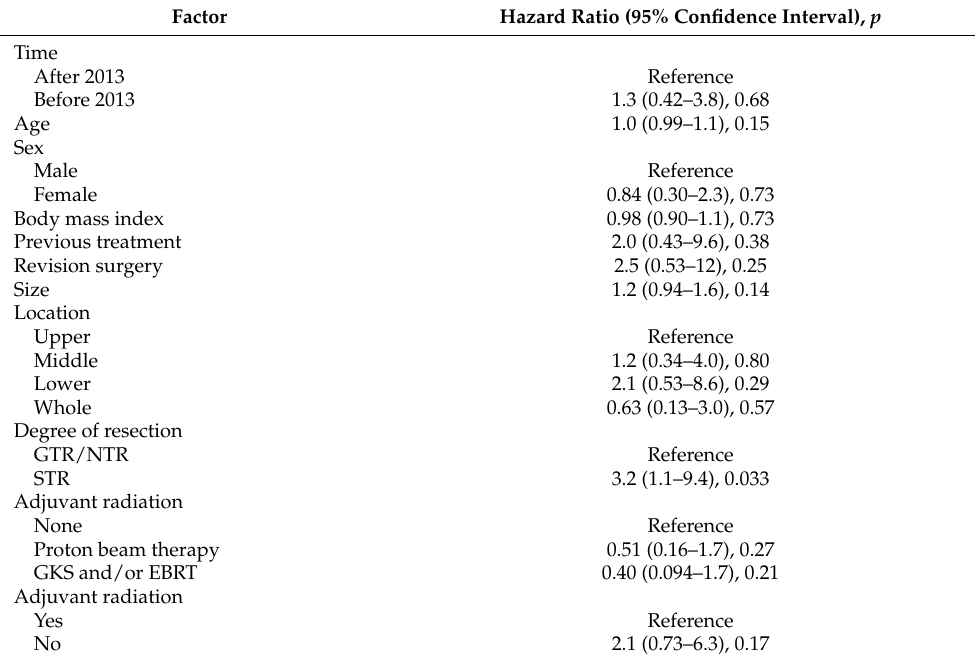
Table 5. The result of Cox regression analysis on a